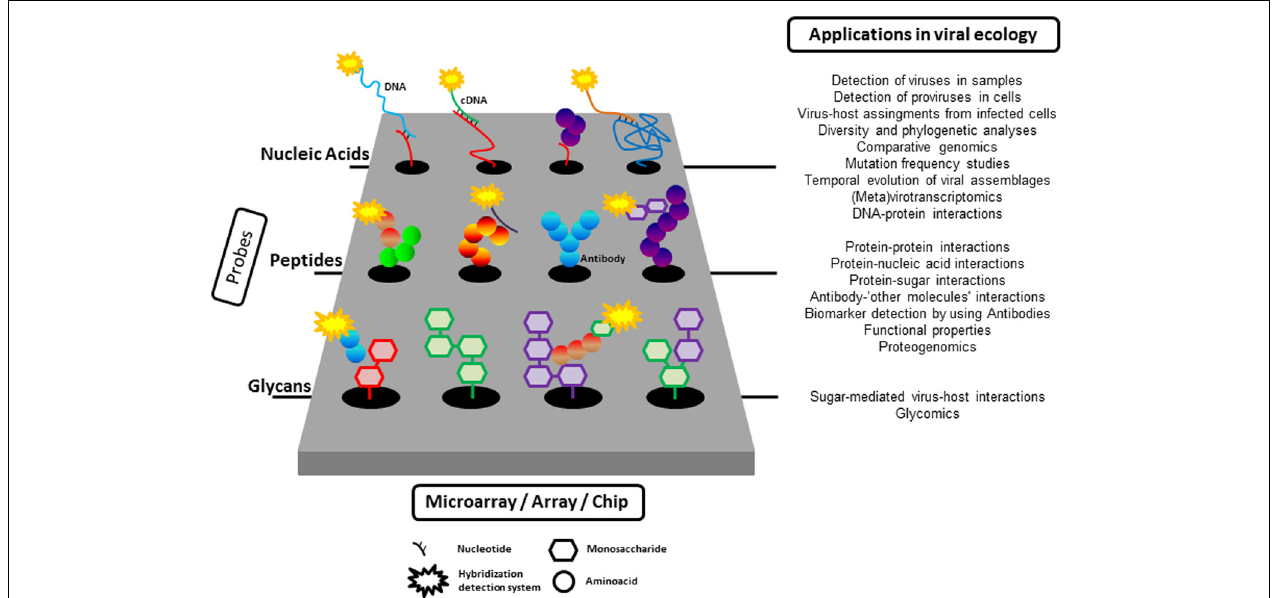
FIGURE 1 | A summary of the application of microarray tools to the study of viral ecology. As described in the text, nucleic acids (from oligonucleotide to complete viral genomes), proteins, or glycans can be immobilized on a solid